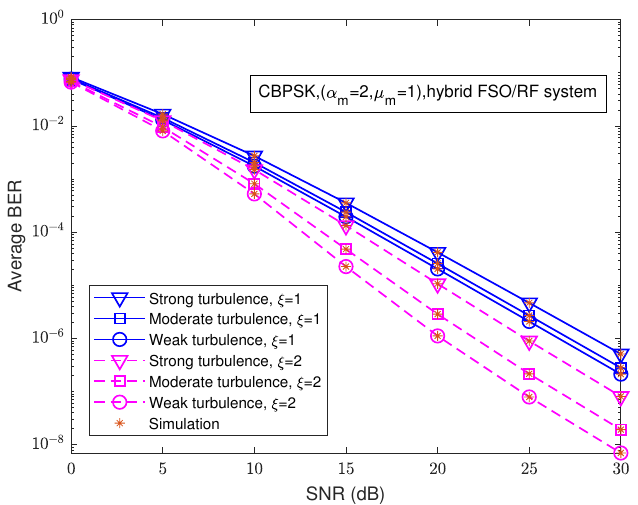
Figure 3. Relationship between BER and SNR of the hybrid system under different turbulence intensity and pointing